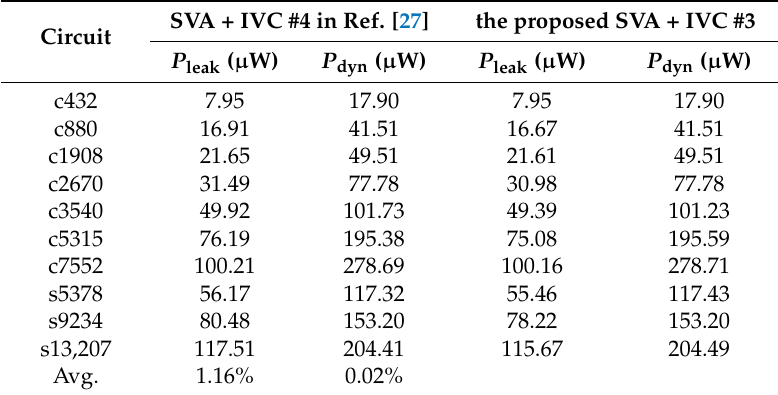
Table 8. Leakage and dynamic power of SVA method using input vector found by Ref. [27] and the proposed ILP